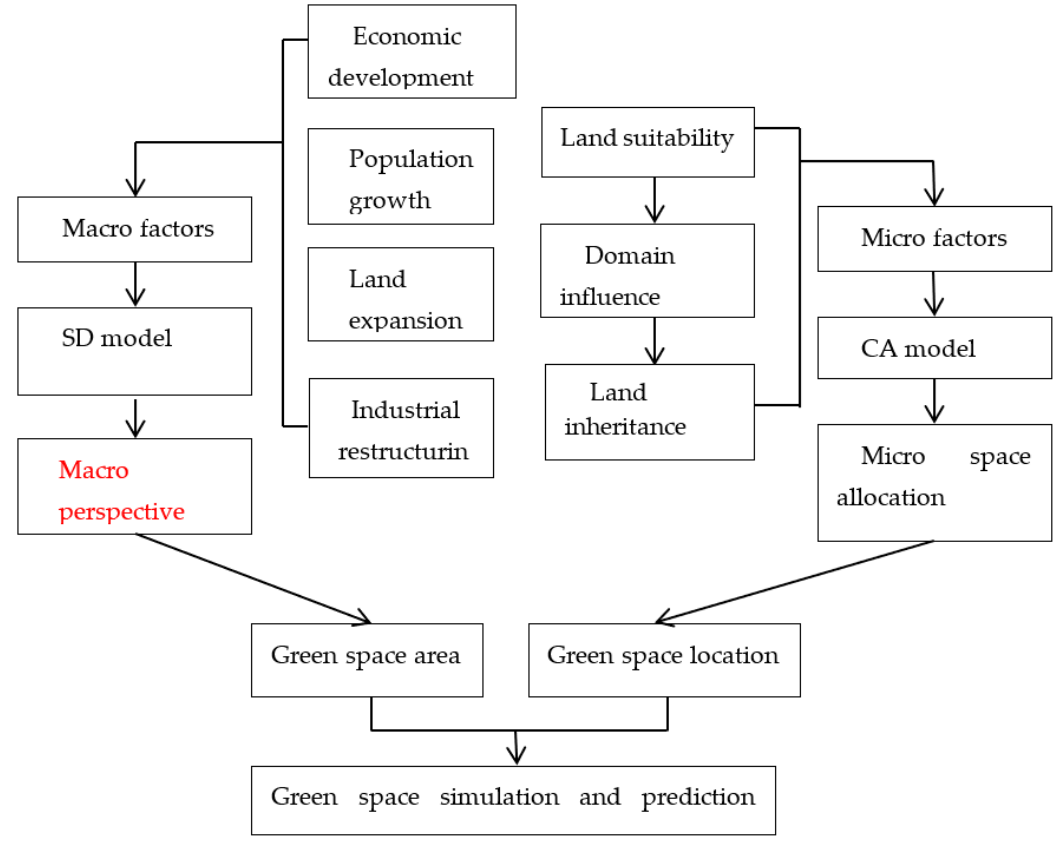
Figure 2. Framework of the SD–CA Coupling Model for Predicting Green Spaces in Beijing’s Central District.